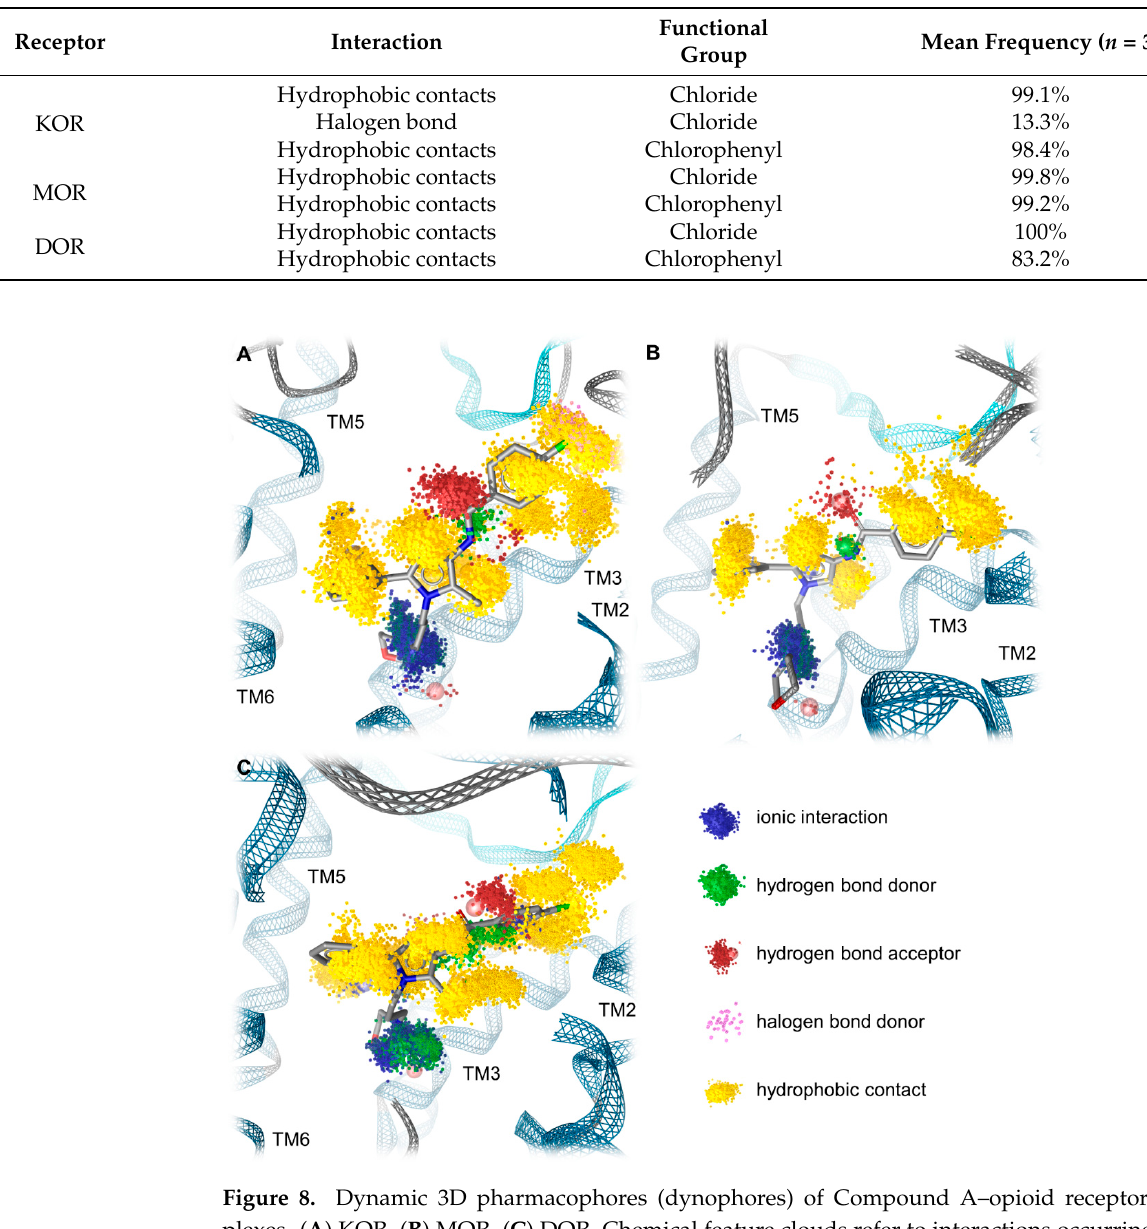
Table 3. Frequency of interactions between the chlorophenyl ring of Compound A and the opioid receptors.